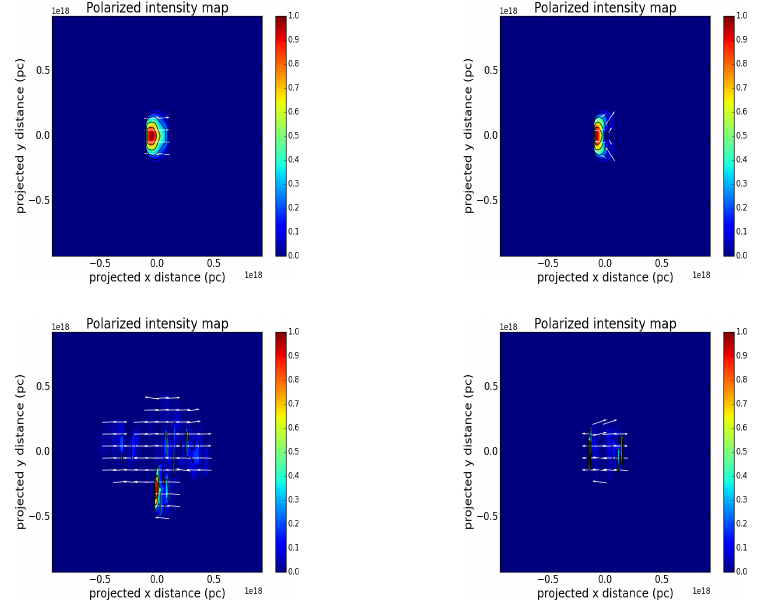
Figure 3. Left: Polarized intensity (normalized) map at t = 0 ( top ) and t = 3 ( bottom ) for σ = 10 − 3 . Right: Polarized intensity (normalized) map at t = 0 ( top ) and t = 3 ( bottom ) for σ = 10 − 1 . The arrows represent the electric field vector, as calculated from Equation (5). Viewing angle is θ obs = 5 ◦ , flow direction is